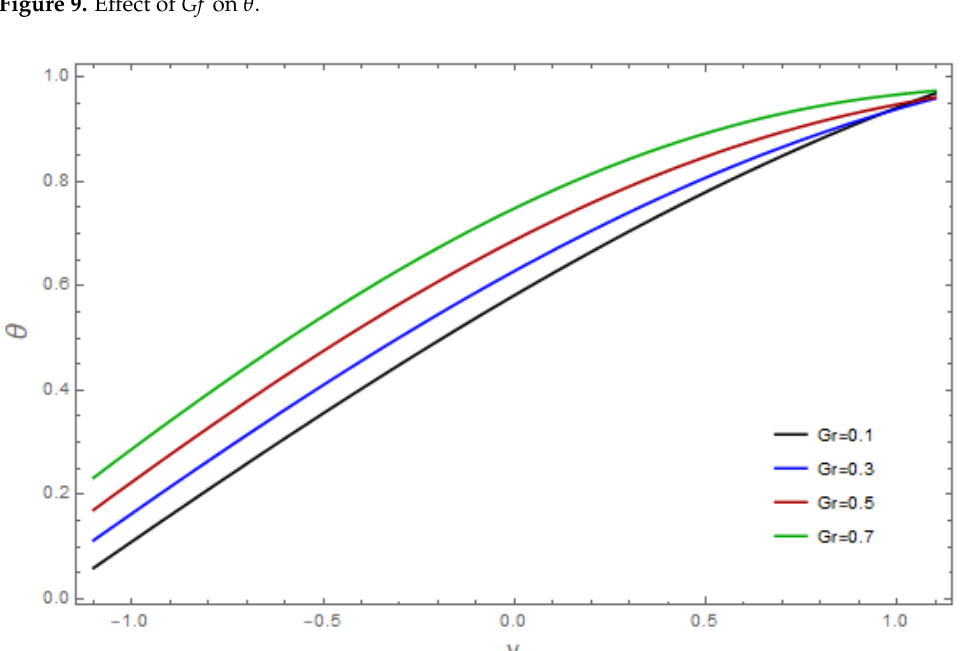
Figure 10. Effect of 𝐺𝑟 on 𝜃 .